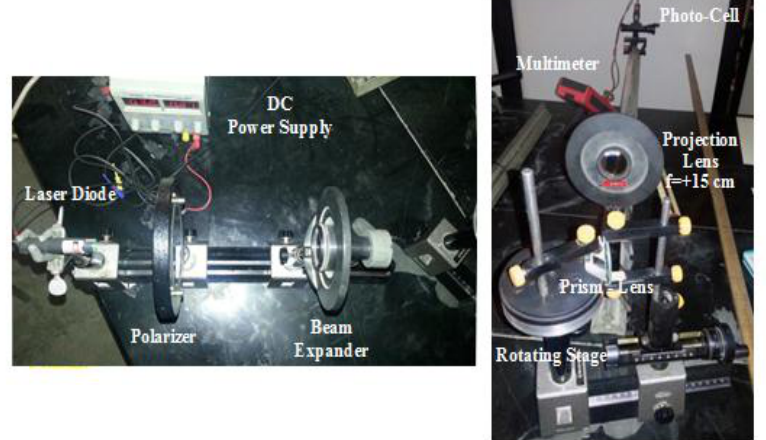
Fig. 1: The experimental setup of the FTIR